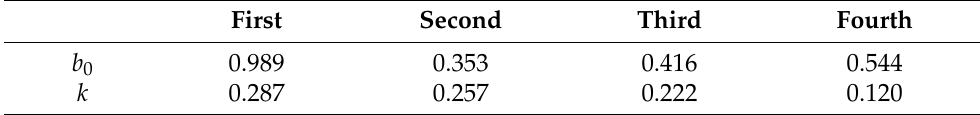
Table 5. Values of b 0 and k for the logarithmic laws. First Second Third Fourth